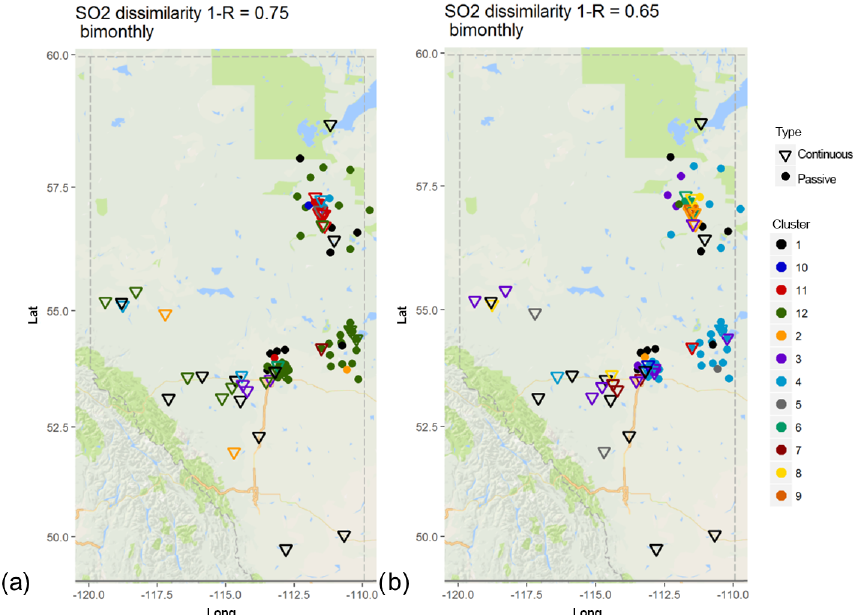
Figure 6. Associativity analysis for passive and continuous bimonthly SO 2 averages for 1 − R = 0.7 ( R = 0.3) Stations are colour-coded according to cluster formation, with continuous stations are marked as triangles and passive stations as circles. The acronyms for the airsheds are as in Fig.